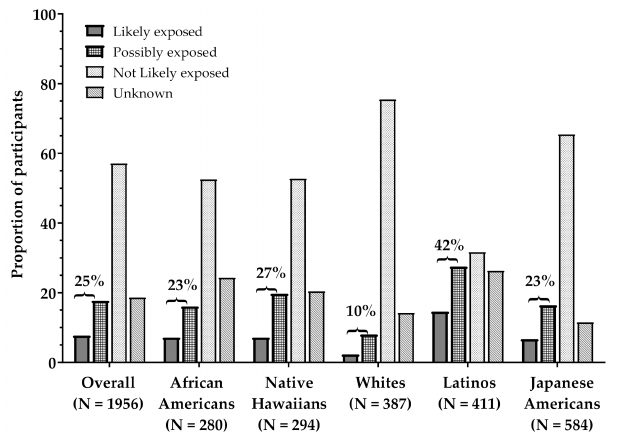
Figure 2. Proportion of Multiethnic Cohort (MEC) current smokers overall and within each racial/ethnic group assigned to occupational Cd exposure categories. Bracketed percentages represent the sum of Likely exposed and Possibly exposed in each group. Table 3. Geometric mean (95% CI) of urinary cadmium concentration (ng/mL) by sex, race/ethnicity and occupational cadmium exposure categories among MEC current smokers.